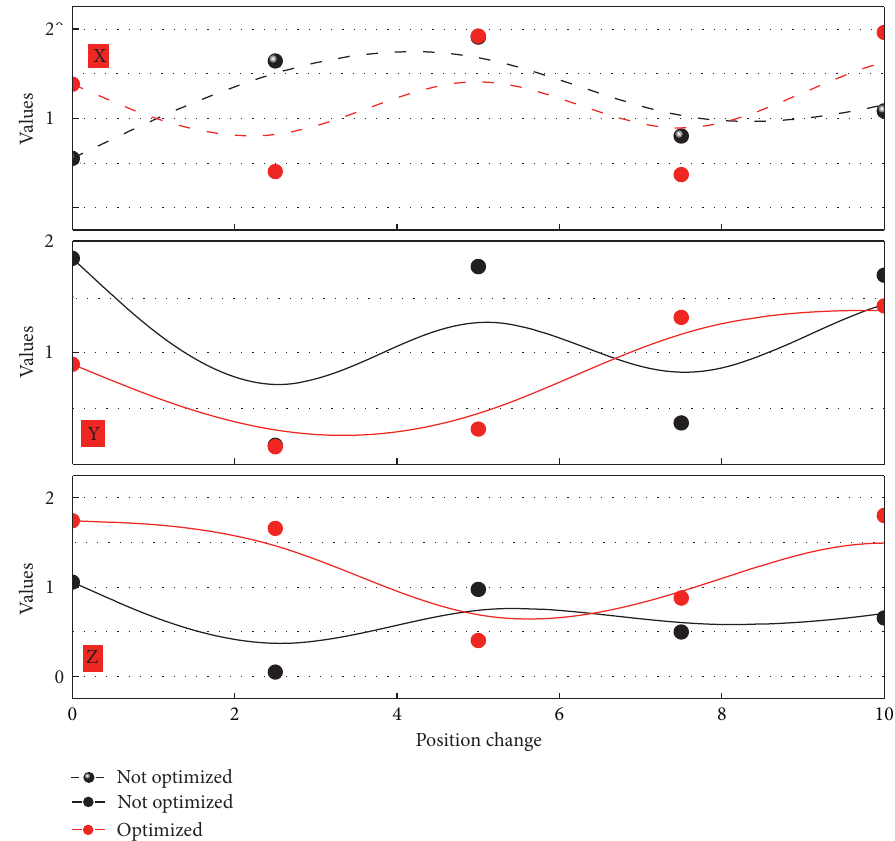
Figure 8: VR-based cell phone sensing position